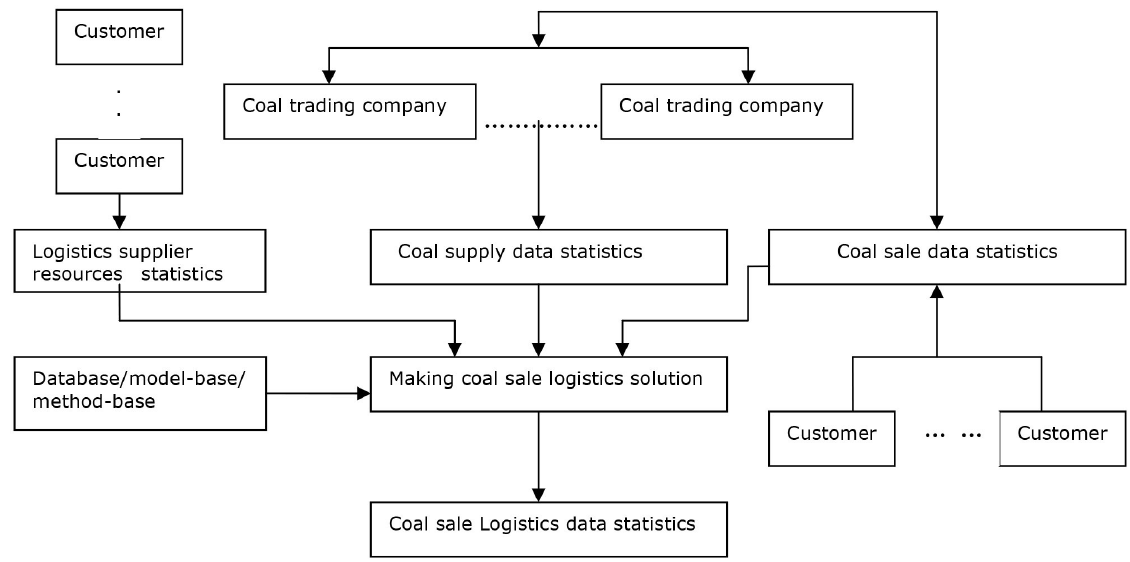
Figure 4. flow diagram of logistics information platform for coal